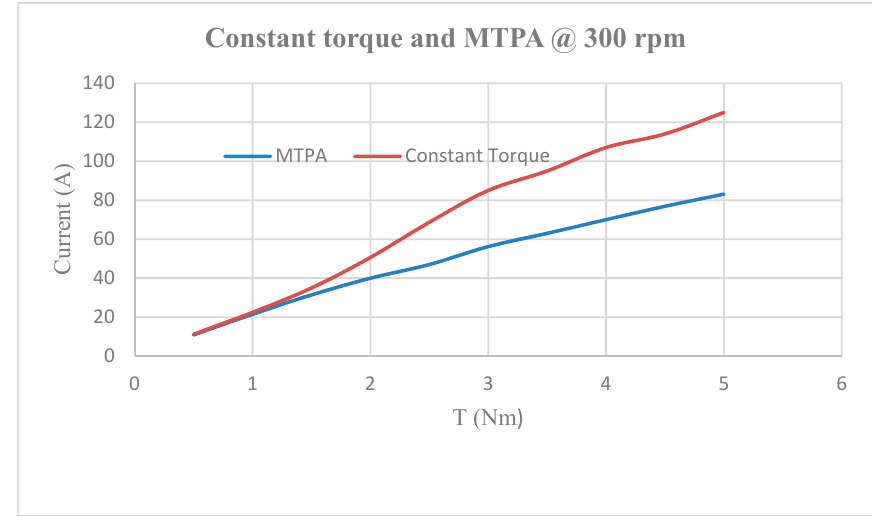
Figure 7. Parameters of IPMSM (taken from HIL).